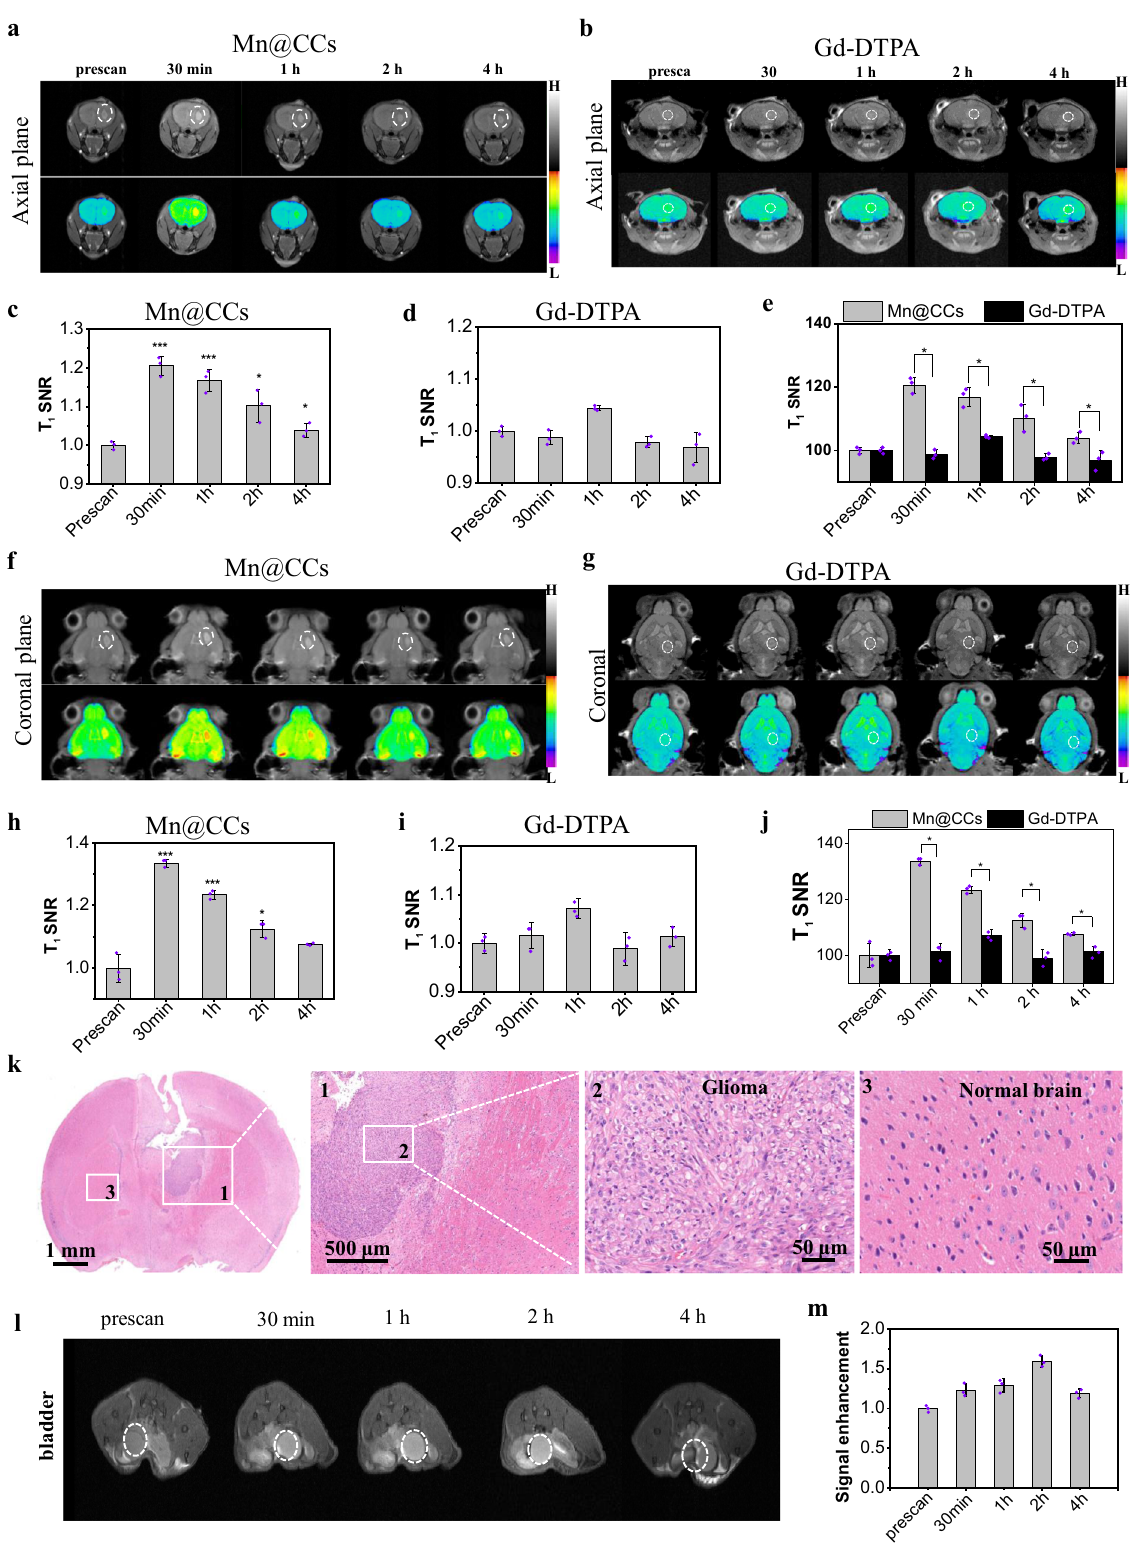
Mn@CCs enable precise magnetic resonance imaging of micro- scopic orthotopic single-nodule brain tumors (about 1 mm) and multinodular liver tumors (each nodule < 1 mm) in